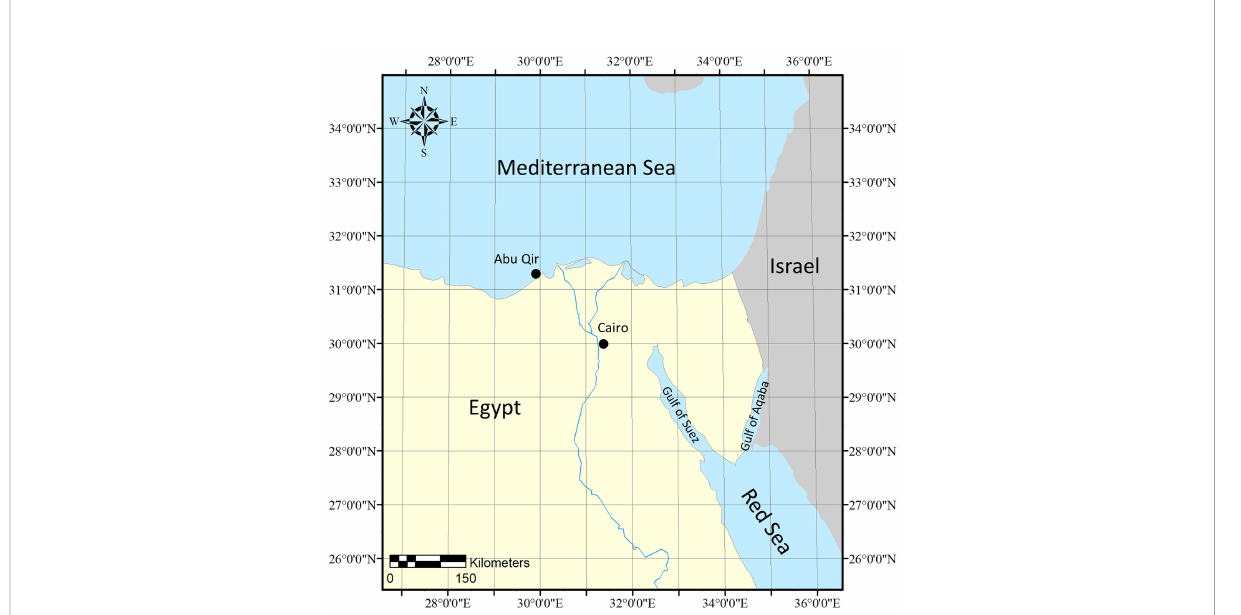
FIGURE 1 Specimen collection map of Phymatolithon abuqirensis vouchers TS 757 and TS 759 collected in the Mediterranean Sea, Alexandria, Abu Qir,